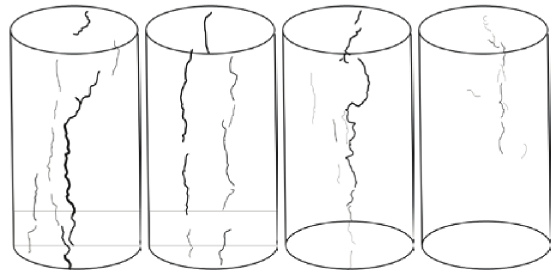
Fig. 5. Sketches of crack patterns: a) control; b) S3/25; c) S3/50; and d) S3/75